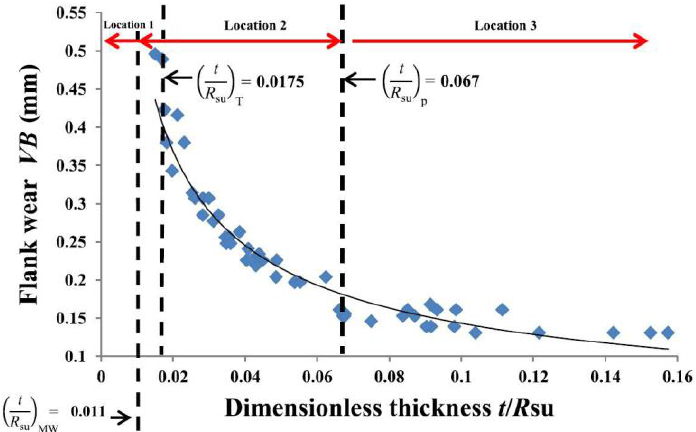
Figure 9. Flank wear vs. dimensionless thickness t / R su with the range of values corresponding to yield inception location in a coated asperity as shown in Figure 2 (taken from [58]).